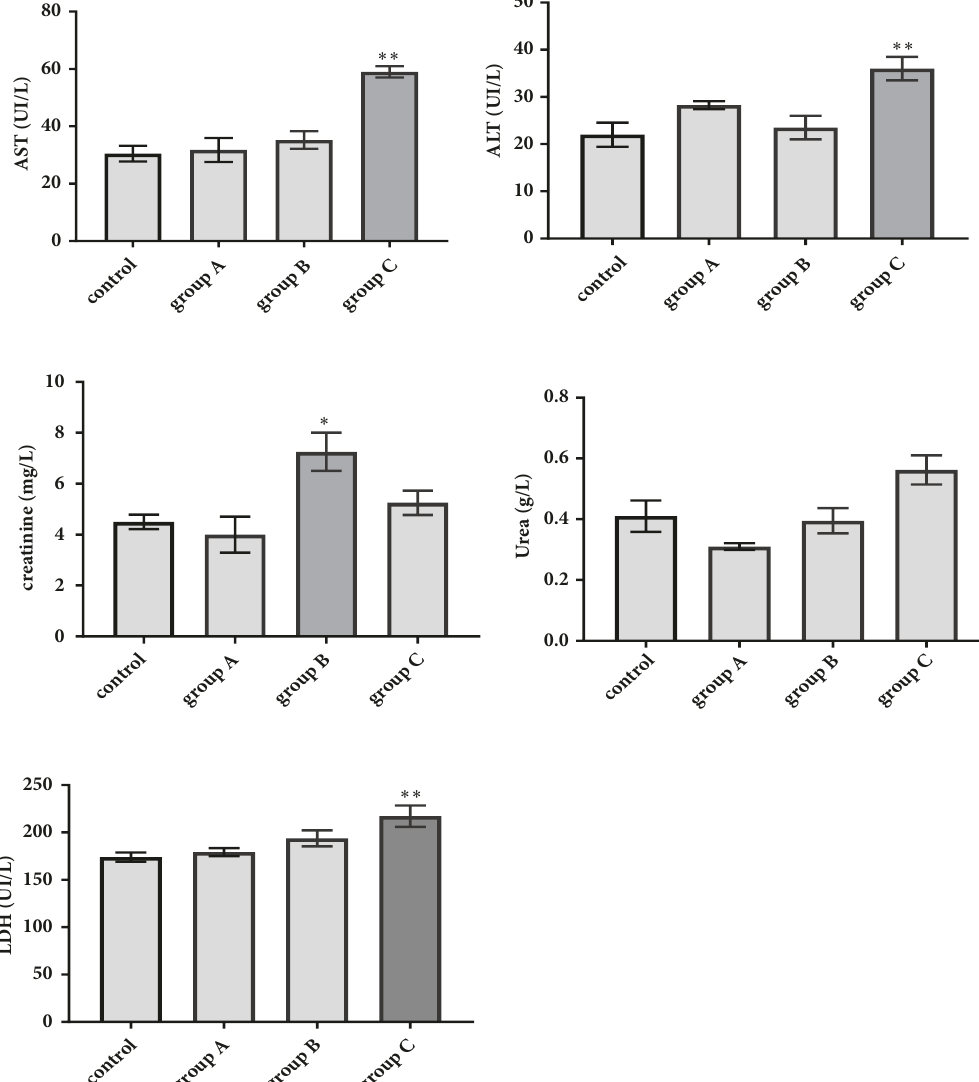
Figure 2: Effect of the plant extract at doses 1 g/kg/day (group A), 1.5 g/kg/day (group B), and 2 g/kg/day (group C) on the transaminases (ALT; AST), urea, creatinine, and lactate dehydrogenase (LDH) after the end of the experiment; results represent the means ± SD (standard deviation).